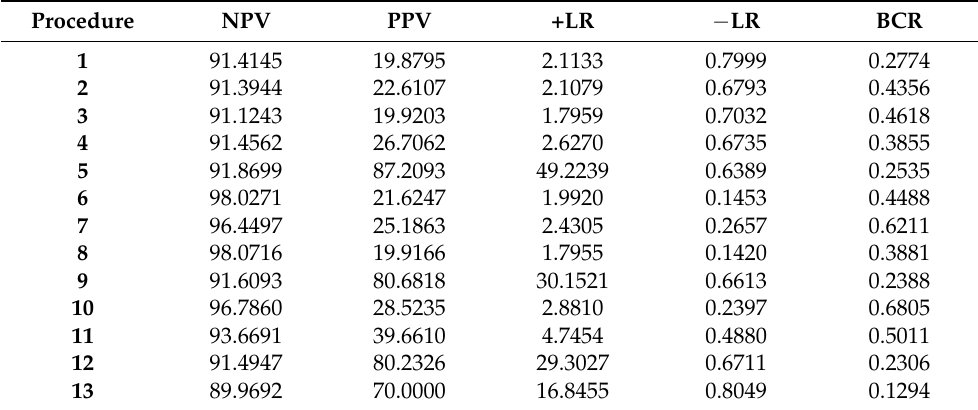
Table 2. PPV (probability of predicted binder), NPV (probability of predicted nonbinder), posi- tive (+LR) and negative ( − LR) likelihood ratios, and BCR (modified correct classification rate) for 13 different procedures for the training set.